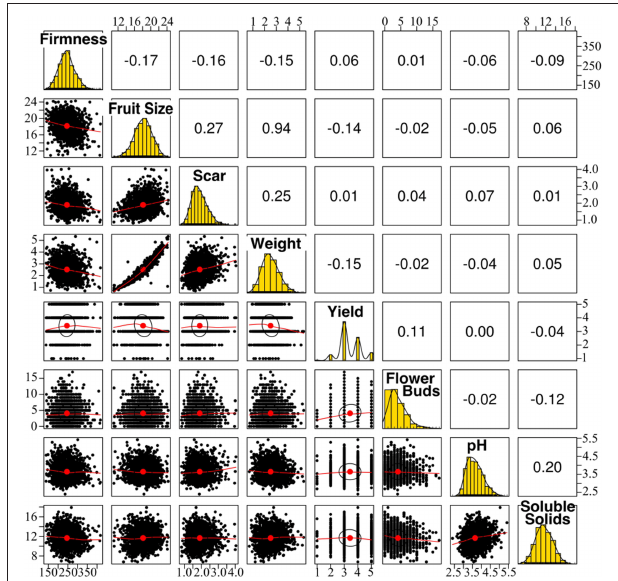
FIGURE 1 | Phenotypic distribution and correlation of eight blueberry fruit-related traits for 1,575 individuals. Plots in the diagonal show the frequency distribution of each trait. Pearson’s correlation coefficient between traits are indicated above the diagonal. Scatter plots below the diagonal illustrate the underlying relationship between